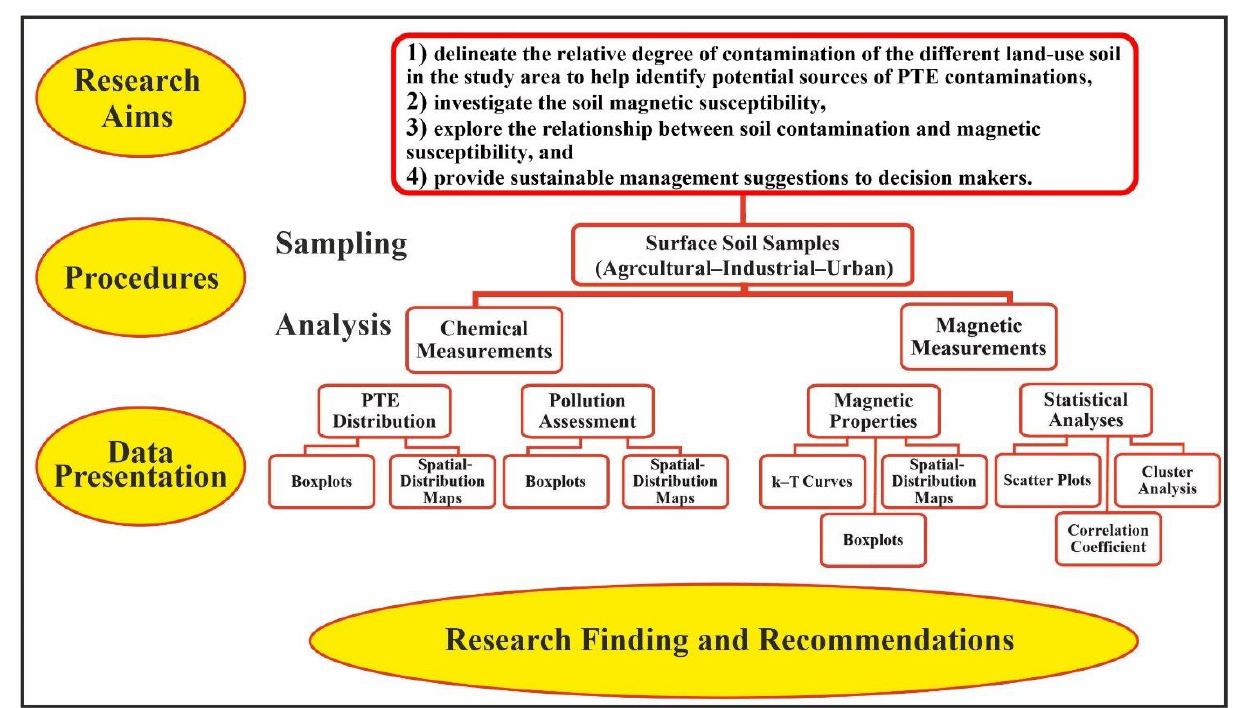
Figure 1. A conceptual model representing research aims and main steps.